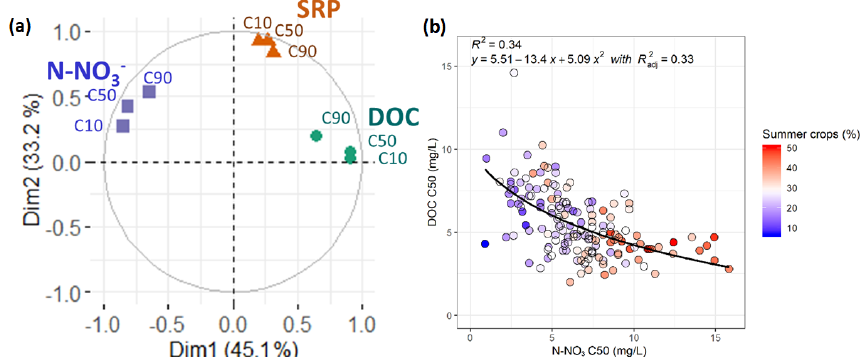
Figure 3. (a) Principal component analysis of 10th, 50th, and 90th percentiles ( C 10, C 50, and C 90) of nitrate (N-NO 3 ), dissolved organic carbon (DOC), and soluble reactive phosphorus (SRP) concentrations for the 185 headwater catchments analysed. (b) Correlation between the medians ( C 50) of DOC and N-NO 3 concentrations for the 159 catchments in which DOC and NO 3 were monitored from 2007–2017. The colour gradient indicates the percentage of catchment area covered by summer crops.